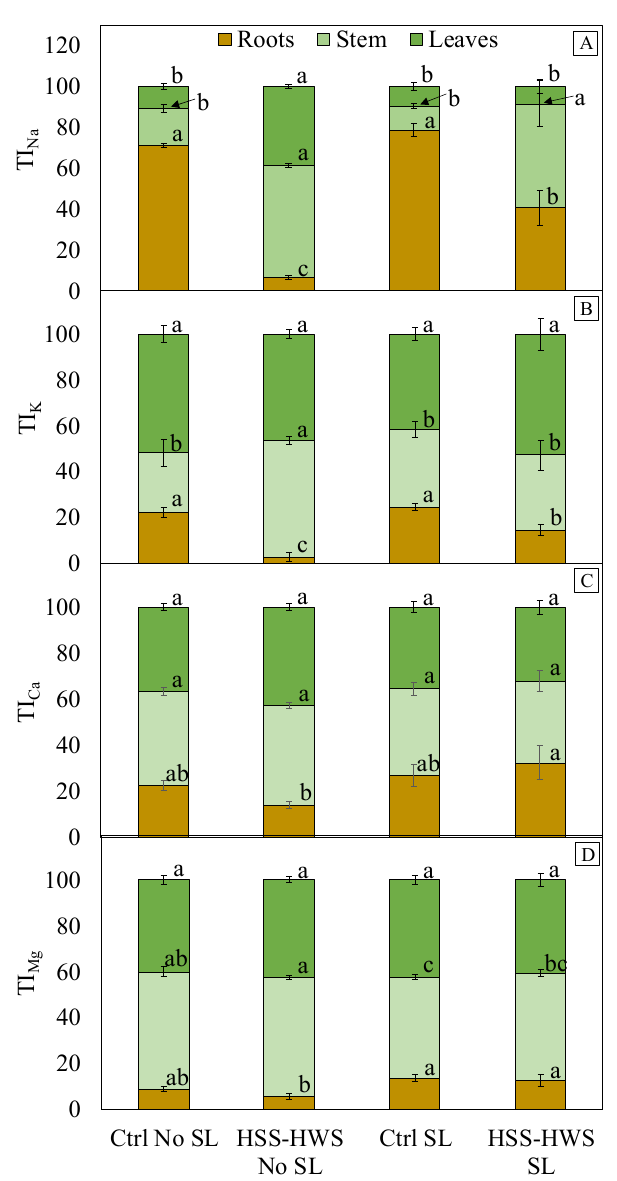
Figure 3. Translocation Index (TI) of (A) sodium, (B) potassium, (C) calcium, and ( D ) magnesium to the roots, stem, and leaves. Ctrl, control; HSS-HWS, high soil salinity and high water salinity; SL, salt leaching. Vertical bars indicate ± standard error (n = 3). Different letters indicate significant differences among treatments at p ≤ 0.05.